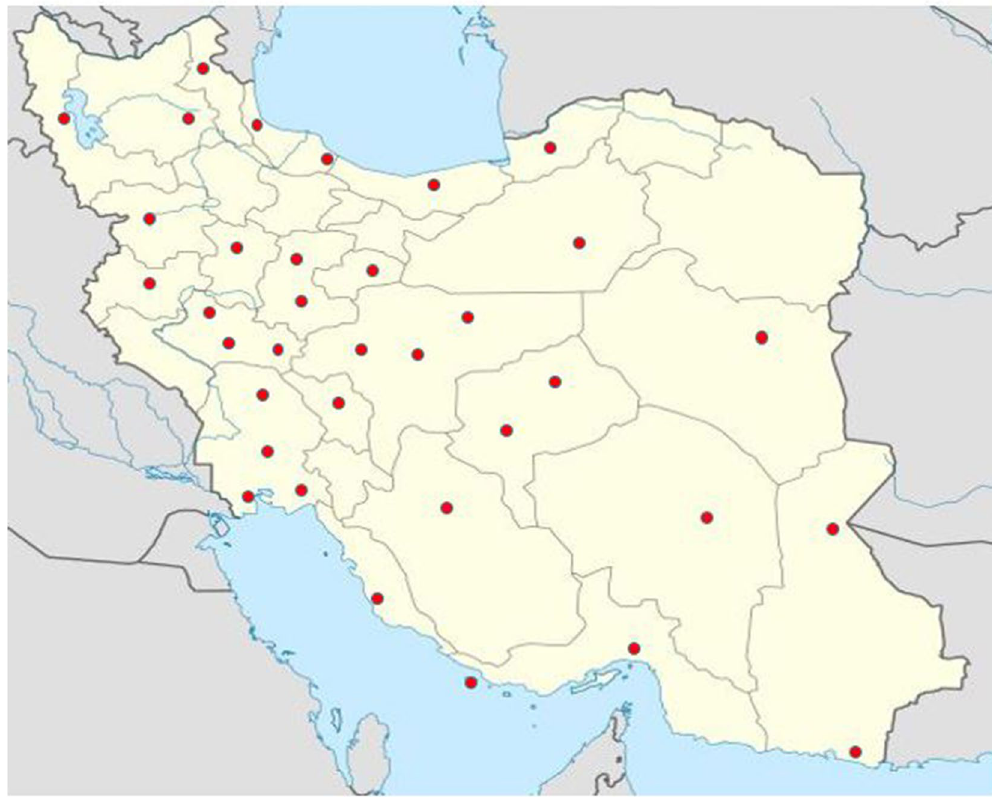
Figure 1. Geographic distribution of sampling sites from Iranian ecosystems. The Figure source is obtained from Google maps and designed by Adobe Photoshop 2017